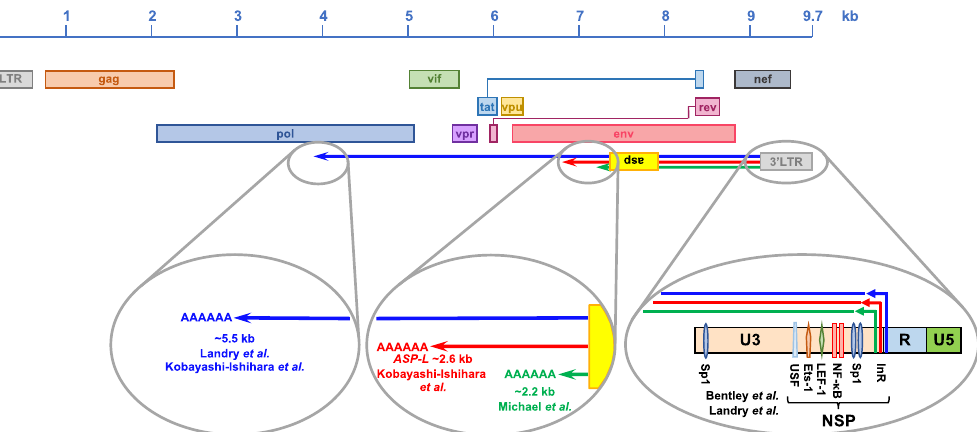
Figure 2. Schematic representation of HIV-1 NATs reported in the literature. The expression of HIV-1 NATs is dependent on a negative sense promoter (NSP) located in the U3 region of the 3′ LTR. NSP is a TATA-less promoter that functions independently of Tat, and which relies on several housekeeping and inducible transcription factors, such as Sp1, NF- κ B, LEF-1, Ets-1 and USF. The start site(s) of HIV-1 NATs are determined by initiator elements (InR) located in proximity to the U3-R boundary. Different research groups have described several NATs associated with the HIV-1 proviral genome. Their lengths vary between 2.2 and 5.5 kb, they all encompass the ORF encoding for the HIV-1 antisense protein (ASP) and they are all polyadenylated.